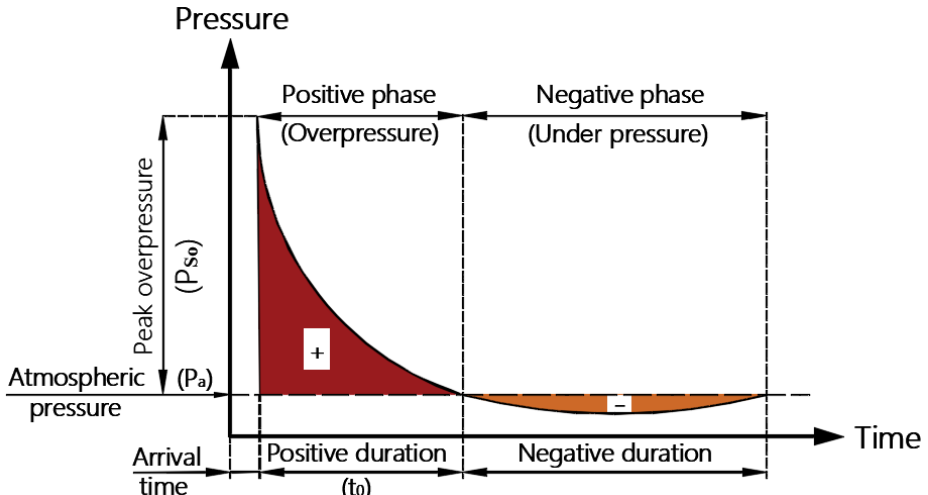
Figure 1. An air explosion ’ s ideal blast wave pressure-time history.